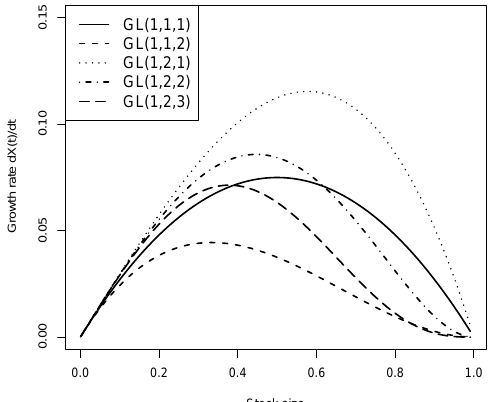
Figure 1. Stock growth rate, dX ( t ) / dt , as a function of stock size, X ( t ) , for several particular cases of the GL model (deterministic case without